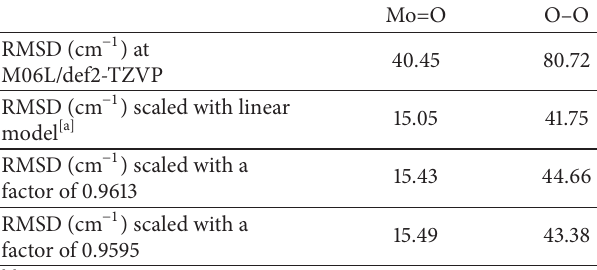
Mo=O O–O 40.45 80.72 15.05 41.75 15.43 44.66 15.49 43.38